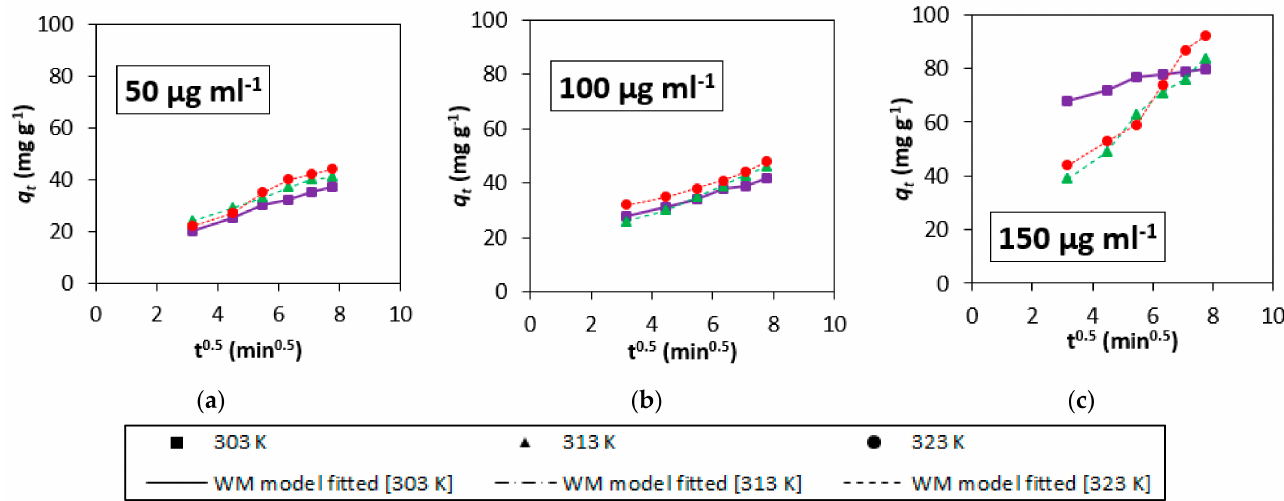
Figure 8. Energy information fitting to format the Weber–Morris model with the beginning BG focus ( a ) 50 µ g/mL, ( b ) 100 µ g/mL, and ( c ) 150 µ